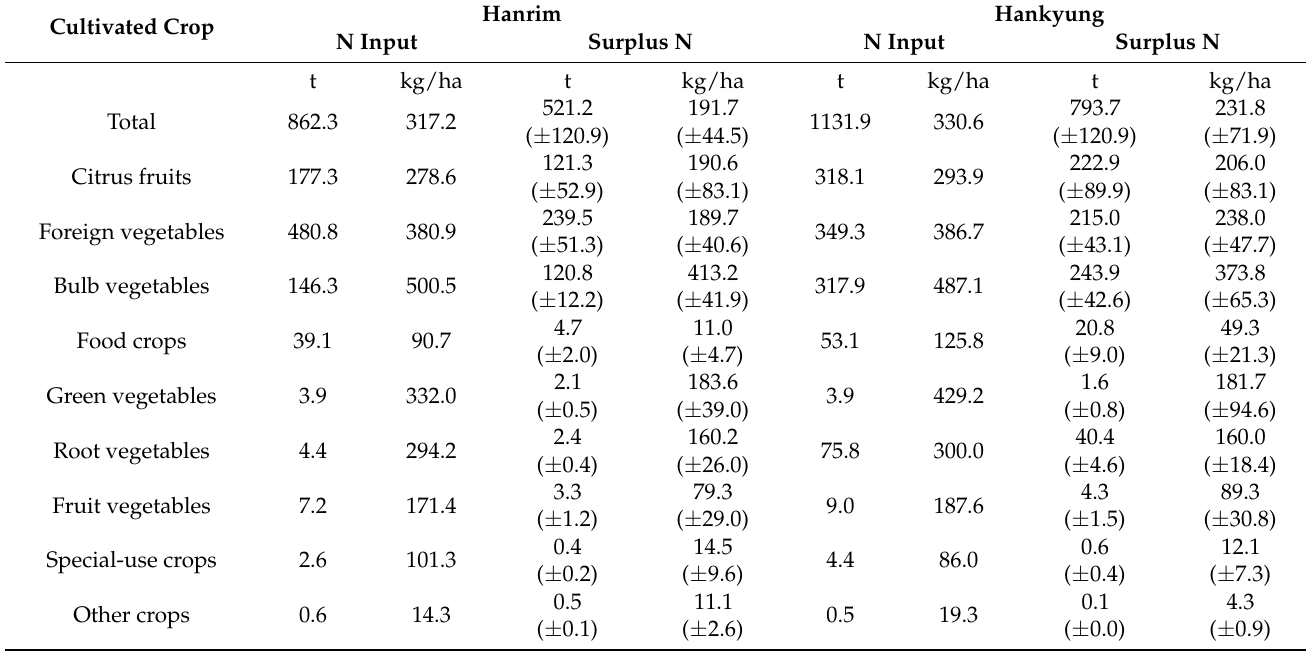
Figure 4. Spatial distribution of ( a ) N input and ( b ) surplus N loading across the study area during the second half of 2018. Table 3. N fertilizer input in the Hanrim and Hankyung